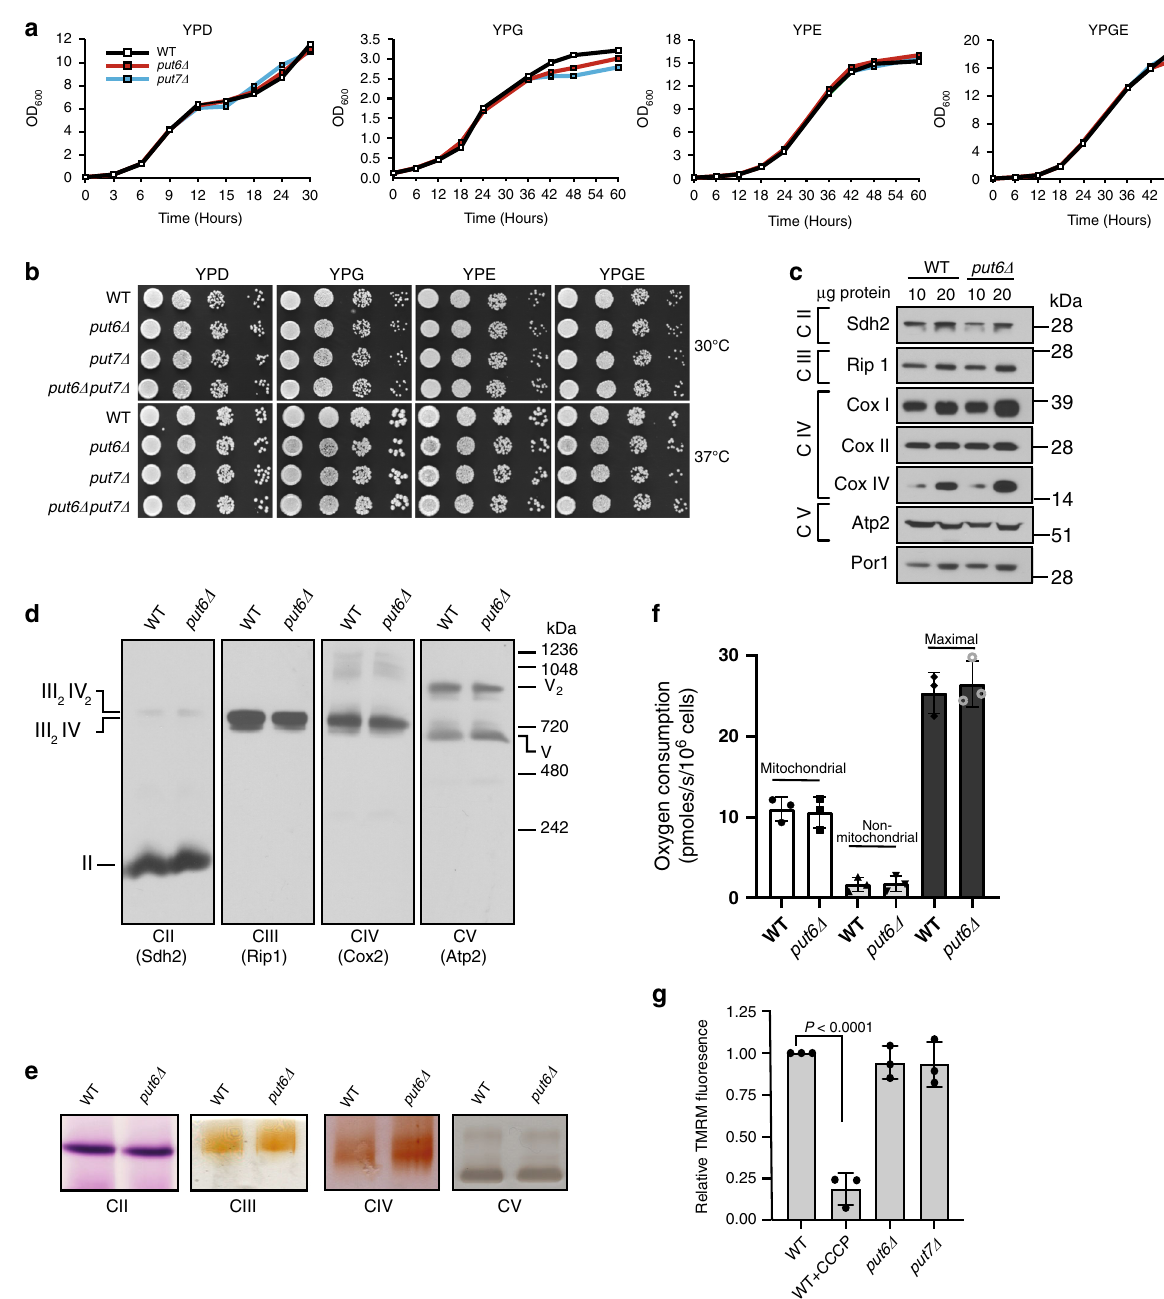
Fig. 3 Put6 and Put7 are not required for MRC function or formation. a , b Put6 and Put7 are not required for respiratory growth. a Growth analysis of WT, put6 Δ , and put7 Δ yeast cells in YPD, YPG, YPE, and YPGE at 30 °C. Absorbance at 600 nm was measured at the indicated time intervals. Data are representative of three independent experiments. b Ten-fold serially diluted WT, put6 Δ , put7 Δ , and put6 Δ put7 Δ yeast cells were seeded on the indicated plates at 30 °C (upper panel) and 37 °C (lower panel). Pictures were taken after 2 (YPD) or 5 (YPG, YPE, and YPGE) days of growth. Data are representative of at least three independent experiments. c Mitochondrial proteins were extracted from WT and put6 Δ yeast cells and analyzed by SDS- PAGE/western blotting using antibodies speci fi c for MRC complexes II – V. Por1 was used as a loading control. Data are representative of three